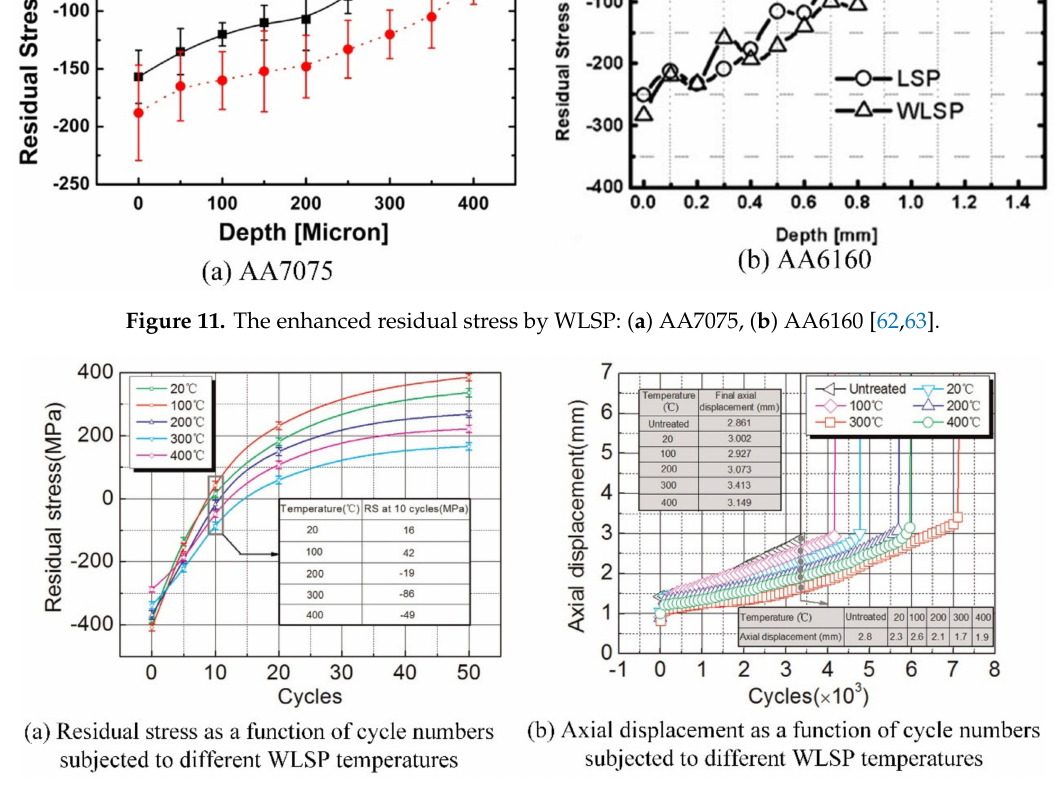
Figure 12. The e ff ects of WLSP on the low-cycle fatigue behavior of Ti6Al4V alloy [64].